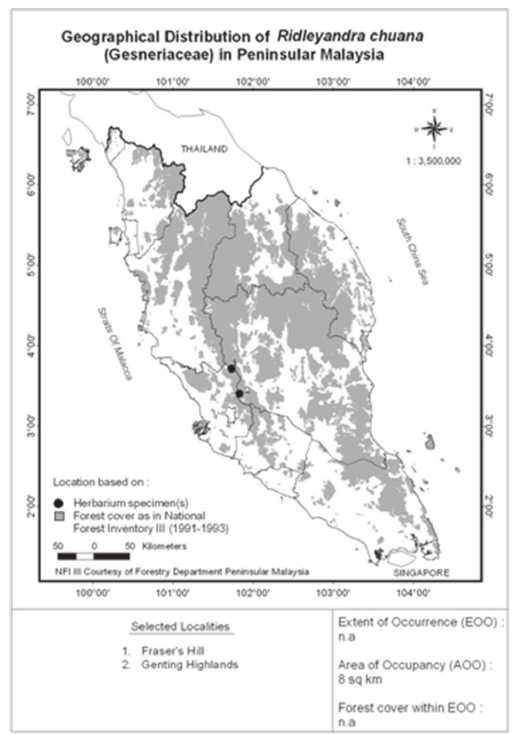
Map 1. Distribution of Ridleyandra chuana in Peninsular